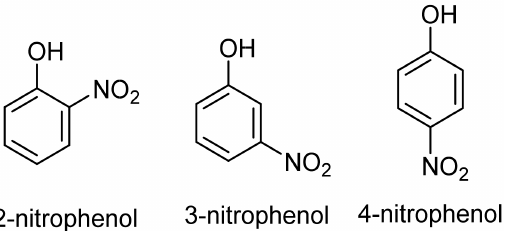
Figure 2. Molecular structures of 2-, 3-, and 4-nitrophenol